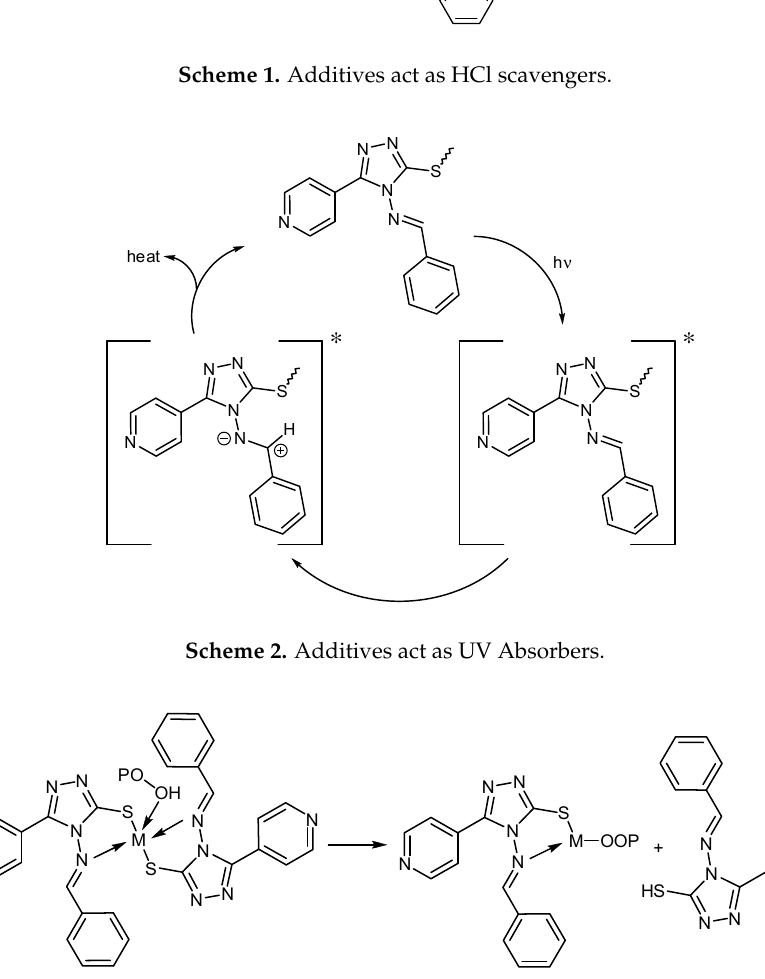
Scheme 3. Additives as peroxide decomposers.